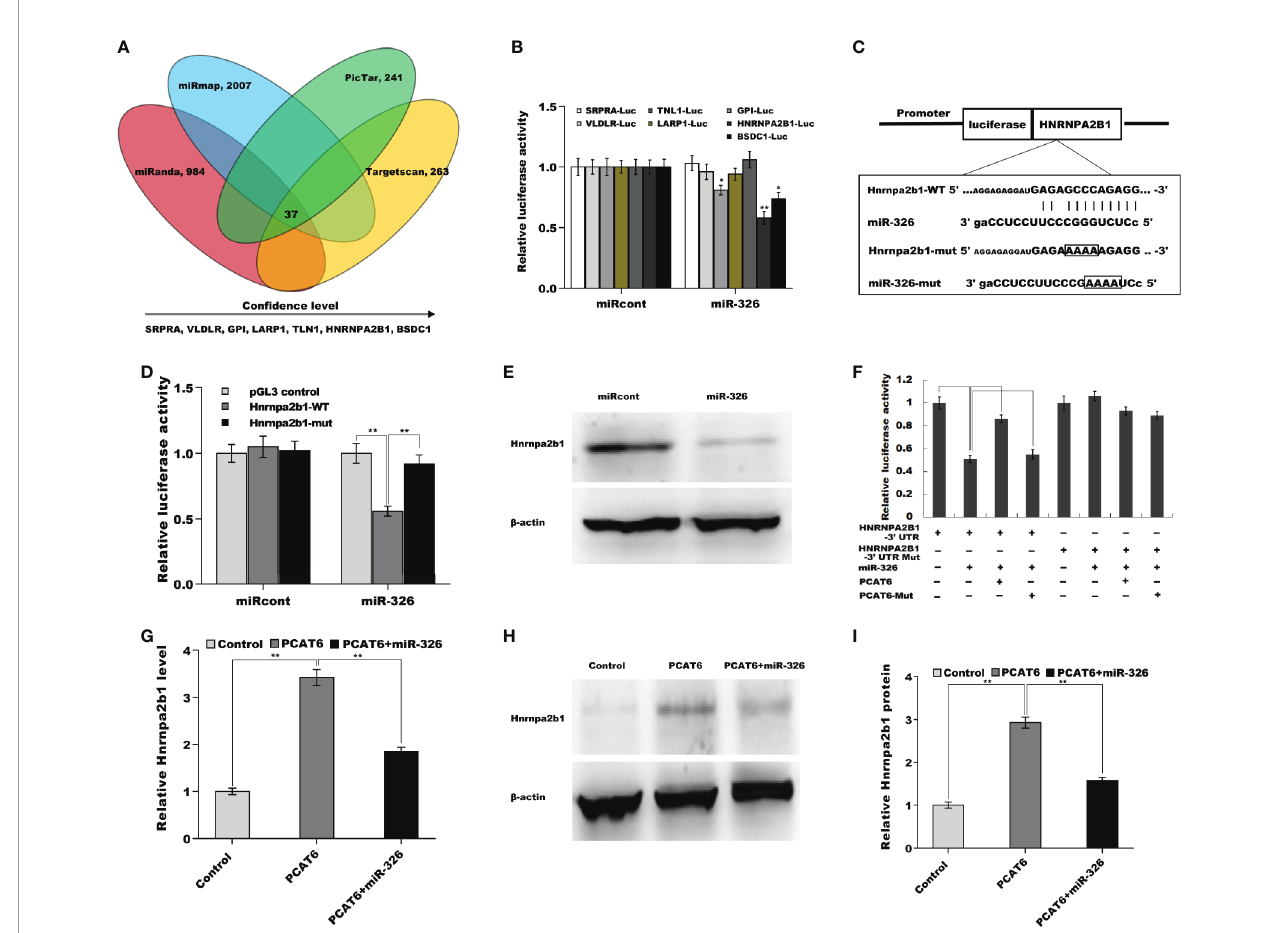
FIGURE 5 | PCAT6 activated Hnrnpa2b1 expression in miR-326-dependent manner. (A) Four bioinformatics algorithms (miRanda, miRmap, picTar, and TargetScan) were used to predict the common target genes of miR-326. (B) Luciferase activity was assayed in NCI-H660 cells co-transfected with luciferase reporters containing SRPRA-WT, VLDLR-WT, TNL1-WT, LARP1-WT, GPI-WT, HNRNPA2B1-WT, or BSDC1-WT and miR-326 or miR-326-Mut. (C) Schematic representation of the miR-326 site in Hnrnpa2b1-3 ’ UTR. (D) Luciferase activity was assayed in NCI-H660 cells co-transfected with miR-326 and luciferase reporters containing Hnrnpa2b1-WT or Hnrnpa2b1-Mut. (E) Western blot analysis for Hnrnpa2b1 protein level in NCI-H660 cells after miR-326 overexpression. (F) Luciferase activity was assayed in NCI-H660 cells co-transfected with luciferase reporters containing Hnrnpa2b1-3 ’ UTR, Hnrnpa2b1-3 ’ UTR-Mut, PCAT6-WT, or